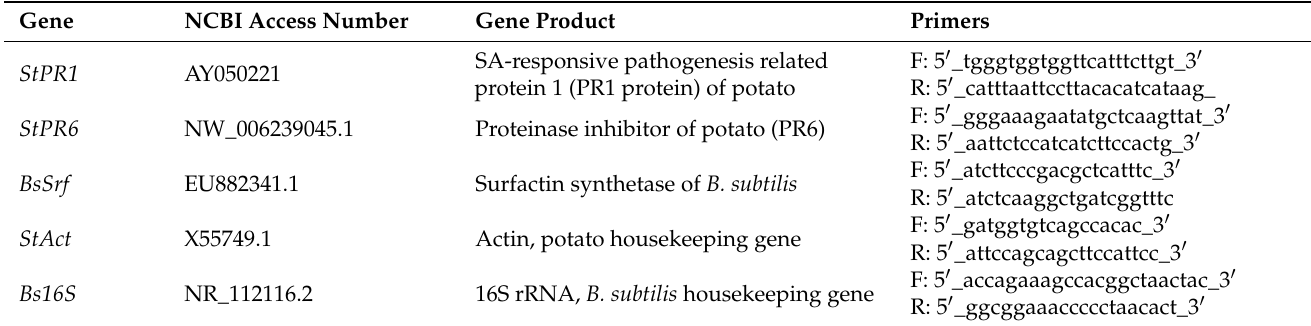
Table 1. Primers used for